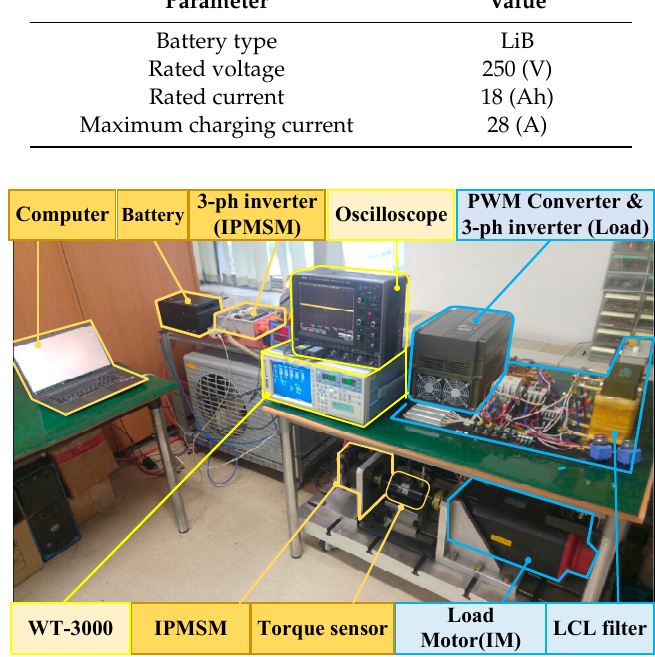
Figure 11. Experimental setup. Table 1. PMSM drive parameters.